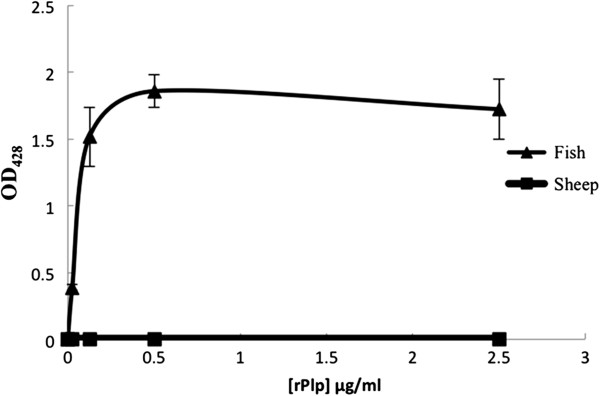
Lysis of Atlantic salmon erythrocytes by recombinant Plp protein (rPlp). 500 μl 5% fish (triangle) and sheep (square) erythrocytes were incubated with various concentration rPlp at 27°C for 20 h. The lysis of erythrocytes was measured at 428 nm. Erythrocyte resuspension buffer (10 mM Tris–HCl, 0.9% NaCl, pH 7.2) was used as negative control. All values were calculated from three independent experiments. Error bars show one standard deviation.